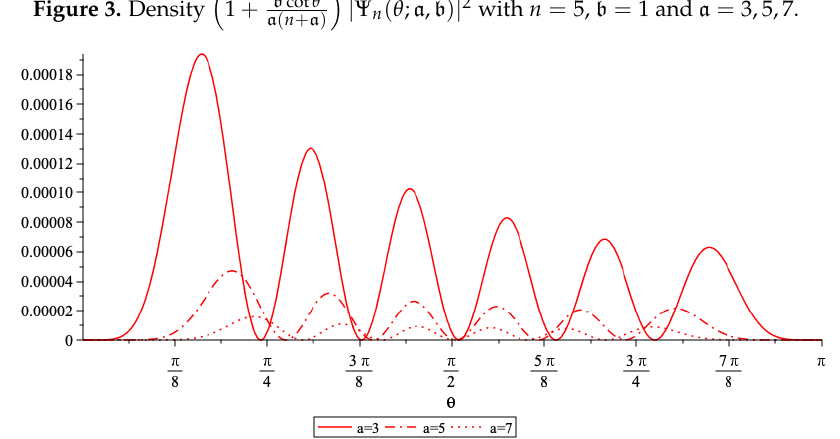
(cid:16) (cid:17) | Ψ n ( θ ; a , b ) | 2 with n = 5, b = 1 and a = 3,5,7. 1 + b cot θ a ( n + a )